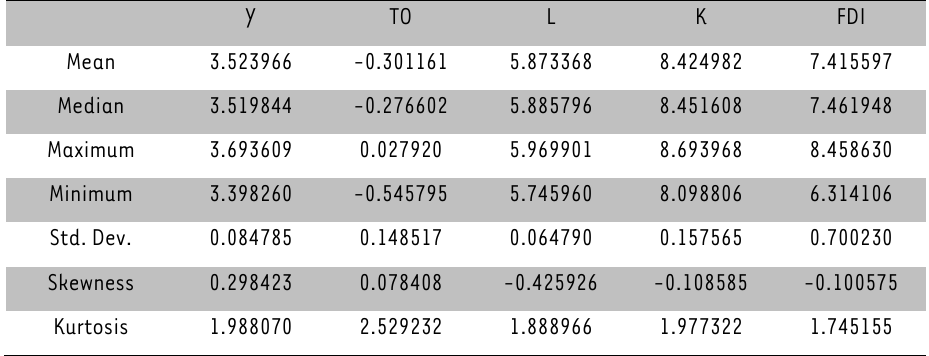
TABLE A3: Descriptive